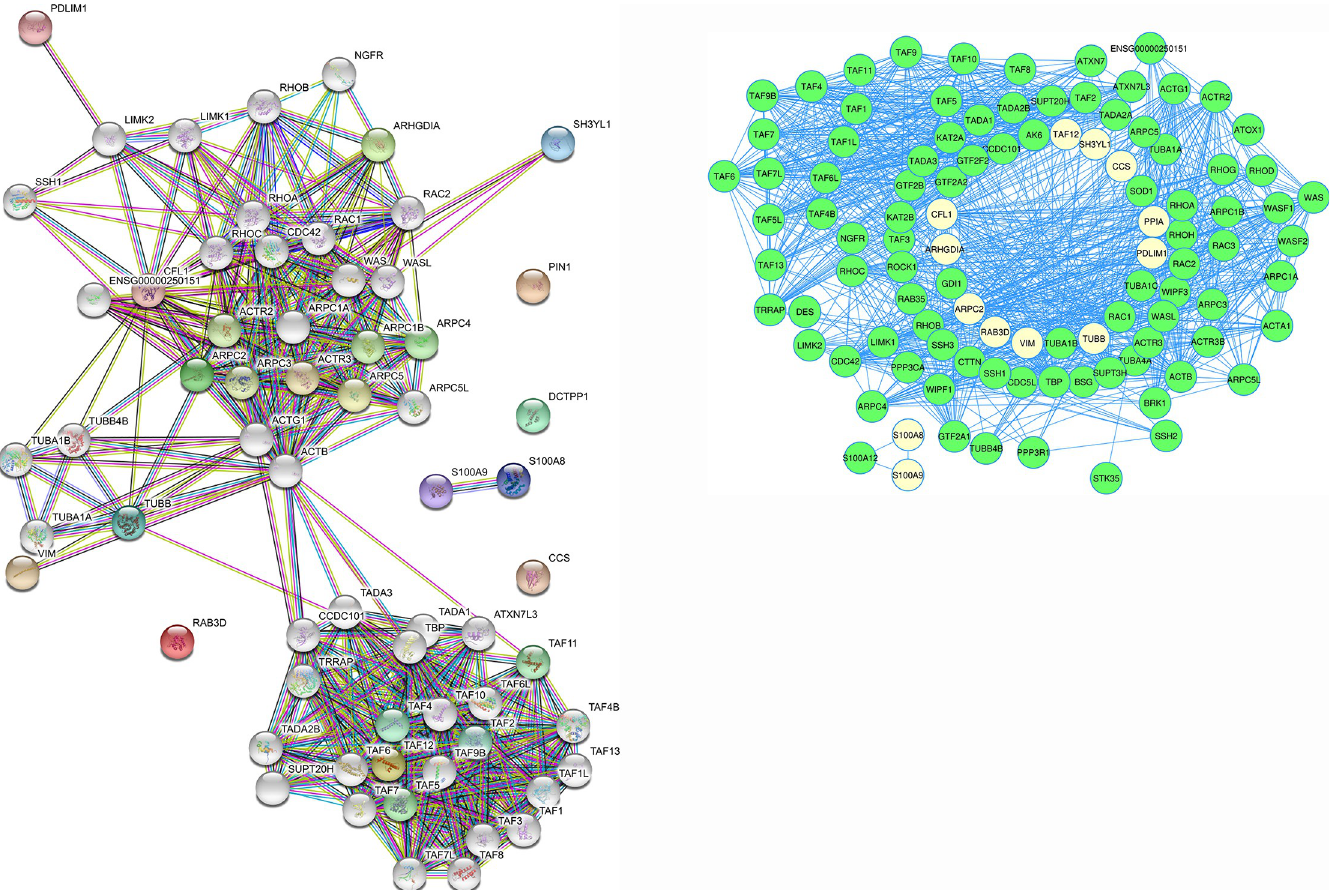
Fig 3. Protein-protein interaction network/pathway analysis by (3a) STRING: Different color nodes in the STRING image represents the individual proteins involved in different networks and (3b) module analysis by Cytoscape 3.8.0: In the Cytoscape network proteins are represented as nodes, and the biological relationship between two nodes is represented as an edge (line). The most significant module in the protein-protein interaction network of differentially expressed proteins Module analysis of cytoscape software (degree cutoff = 2, node score cutoff = 0.2, K-core = 2, and Max. depth = 100). White nodes in the cytoscape network represented differentially expressed